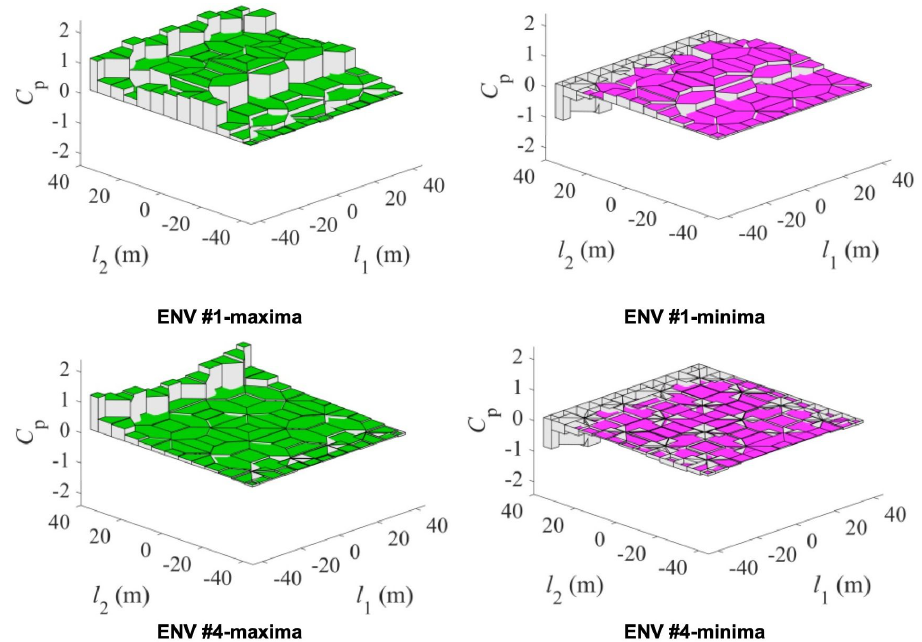
Figure 14: Examples of design pressure coeflcient combination, C p × 𝛾 , for θ = 0